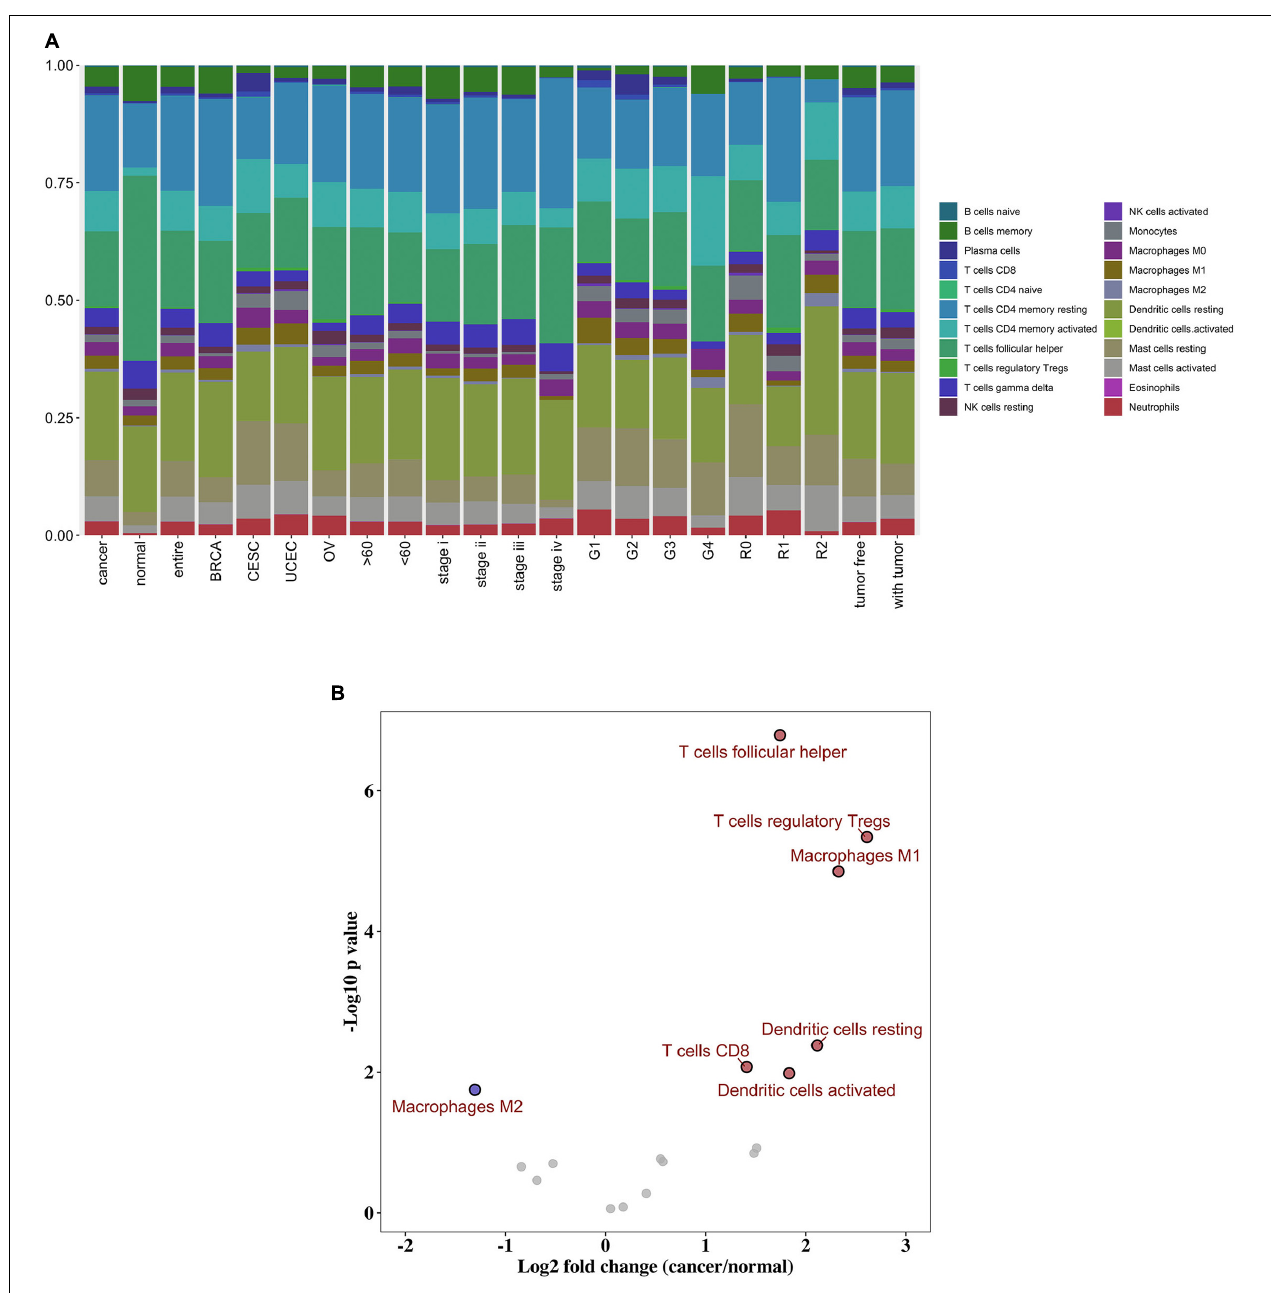
FIGURE 2 | Composition of immune cells in gynecological malignant tumors. (A) Summary of inferred immune cell subsets. (B) Volcano plot visualized the differentially infiltrated immune cells between tumor tissues and normal tissues. Red represents up-regulated, while blue represents